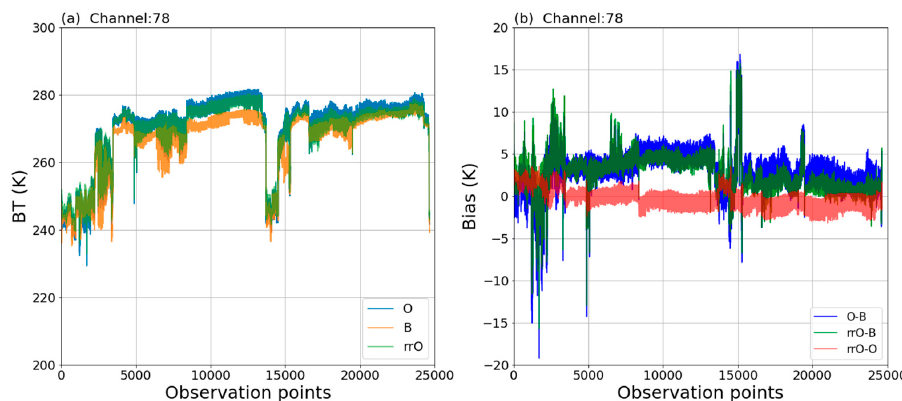
Figure 5. Temperature Jacobians of GIIRS longwave infrared channels. The black dotted line indicates channel 78.